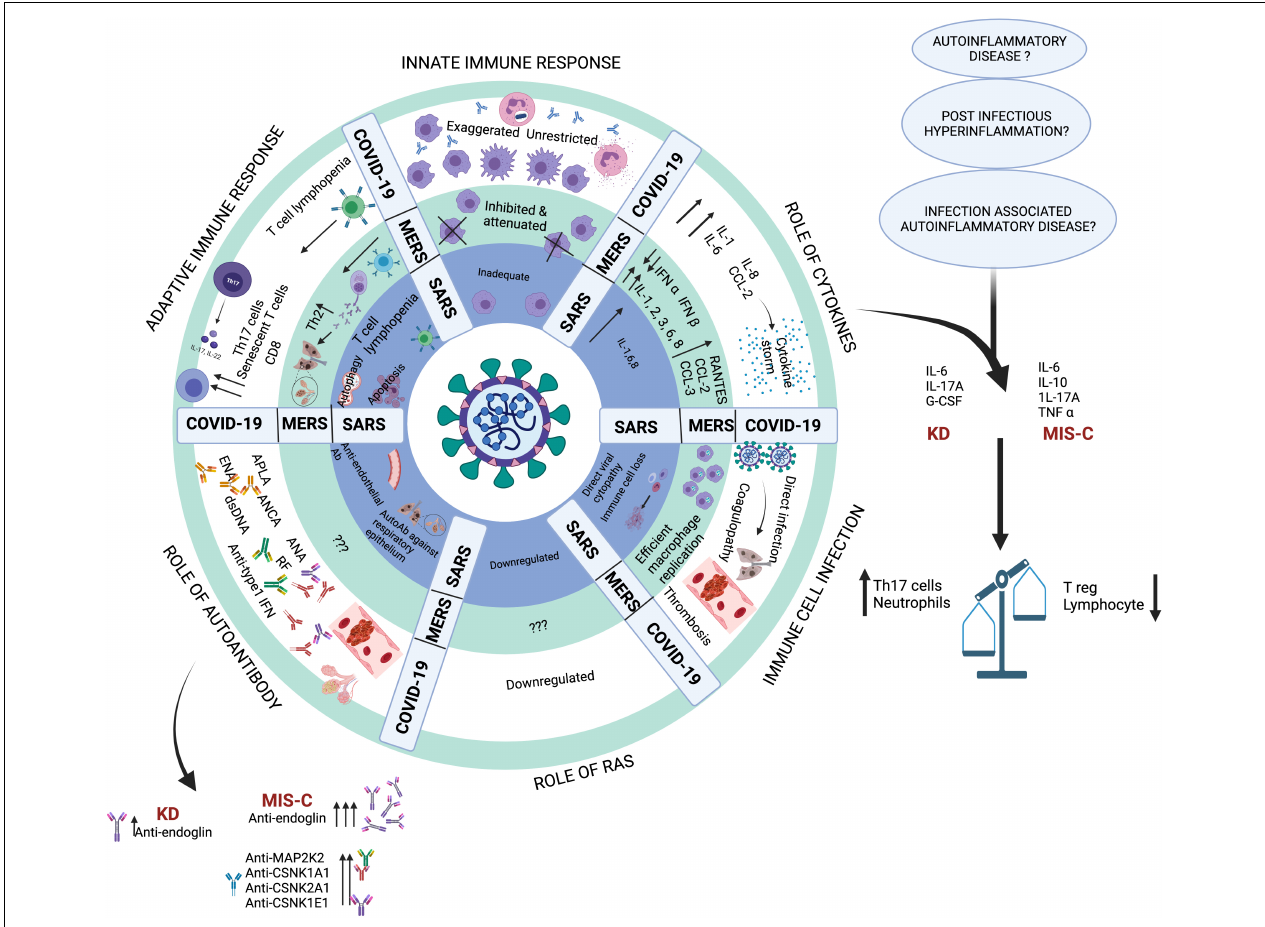
FIGURE 4 | Key pathogenic mechanisms in SARS, MERS and COVID-19. Created with